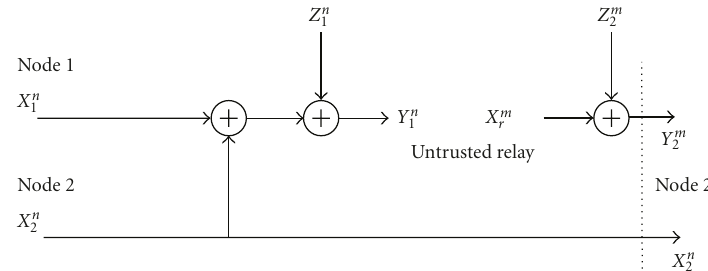
Figure 3: Equivalent Channel Model for Deriving the Upper Bound.